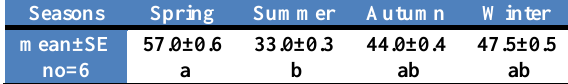
Table, 3: Germinal thickness (µm) during different seasons in